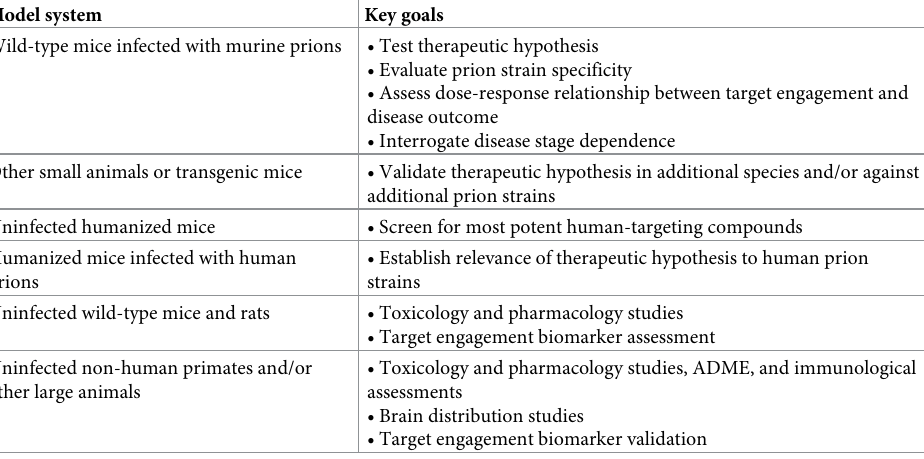
Table 2. Potential roles of different animal models in prion disease drug